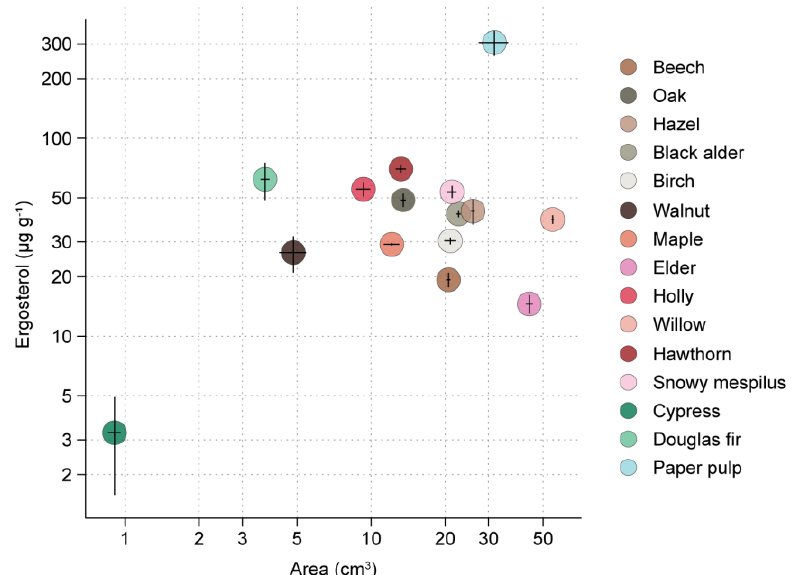
Figure 3. Performance of R. solani on 14 types of wood sawdust and paper pulp. The area of the substrates colonized by the mycelium of R. solani is shown on the x axis (mean ± SE, n = 5), whereas the y axis shows the ergosterol concentration of the substrate in the zone covered by Rhizoctonia hyphae, as a proxy for mycelial density (mean ± SE, n = 5). Both axes are